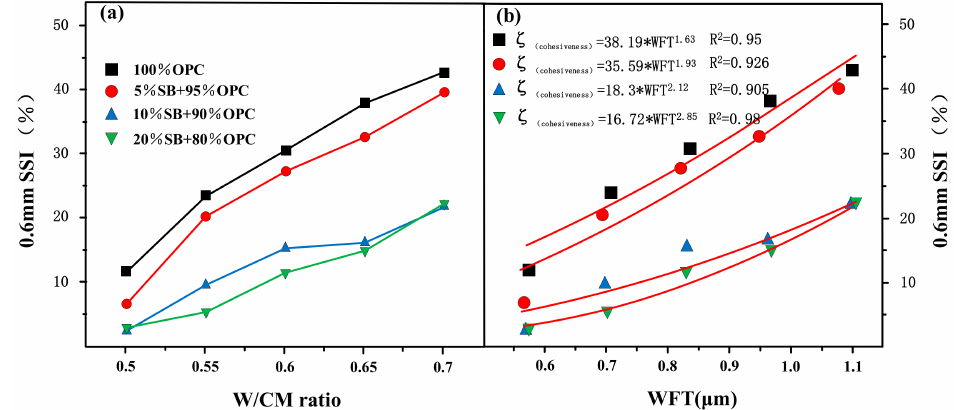
Figure 7. Cohesiveness versus W/CM ratio ( a ) and WFT ( b